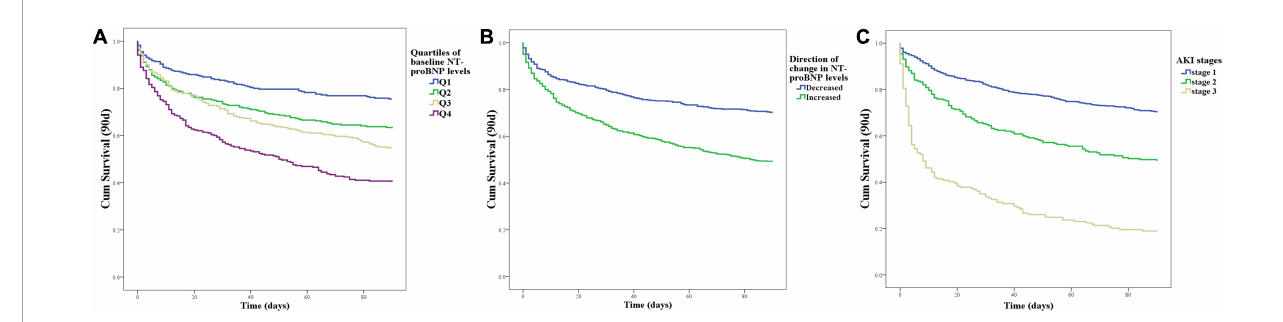
FIGURE1 Patient survival on day 90 with respect to the NT-proBNP levels or AKI stages. (A) Kaplan–Meier curves for 90-day mortality with respect to the four quartiles of baseline NT-proBNP levels at baseline. (B) Kaplan–Meier curves for 90-day mortality with respect to the direction of change in NT-proBNP levels accompanied by an episode of AKI. (C) Kaplan–Meier curves for 90-day mortality with respect to the AKI stages.